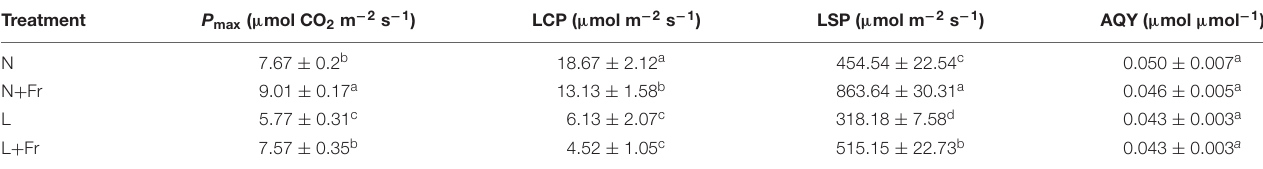
TABLE 1 | Light response model parameters of soybean seedlings under different light intensity and quality treatments.